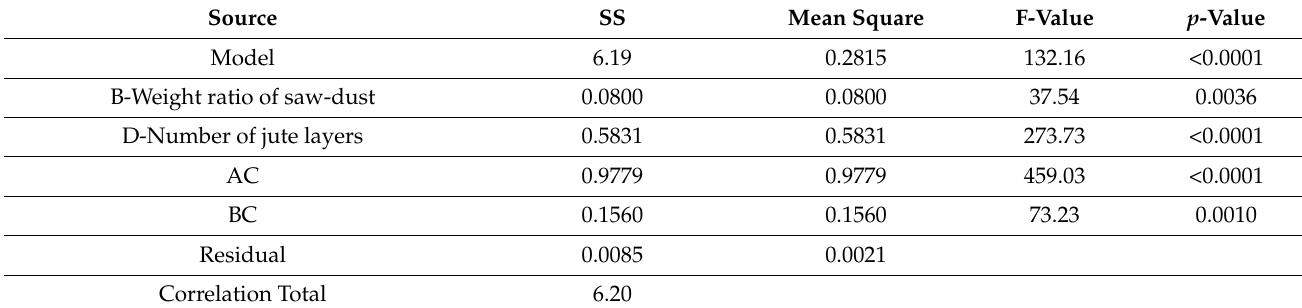
Table 6. Results of ANOVA for impact strength including only the significant parameters.